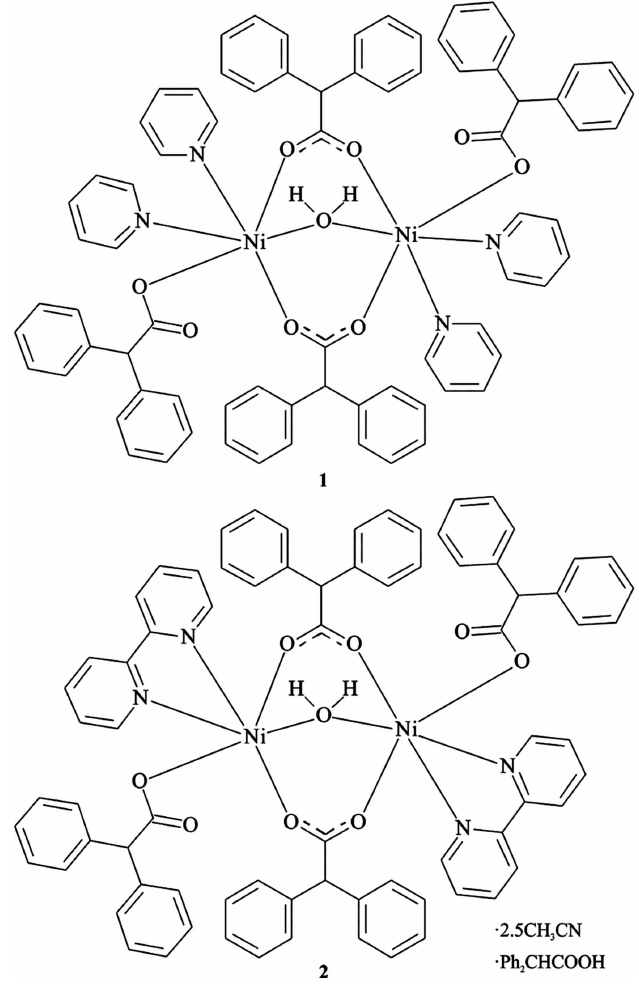
coordinated diphenylacetate ligand is involved in the forma- tion of an intramolecular hydrogen bond with a bridging water molecule. Hydrogen-bond geometries are specified in Tables 1 and 2.